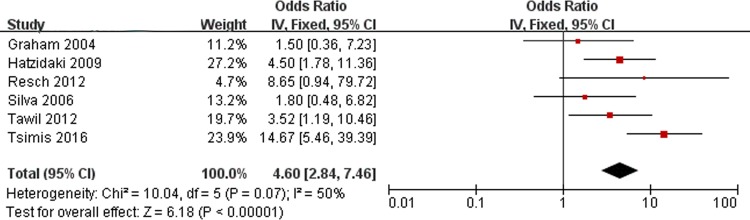
Fixed-effect model forest plot of the odds ratio of the association between seizures and PVL.The pooled OR of seizures is presented as a solid diamond at the bottom of the forest plot, the width of which represents the 95% CI.